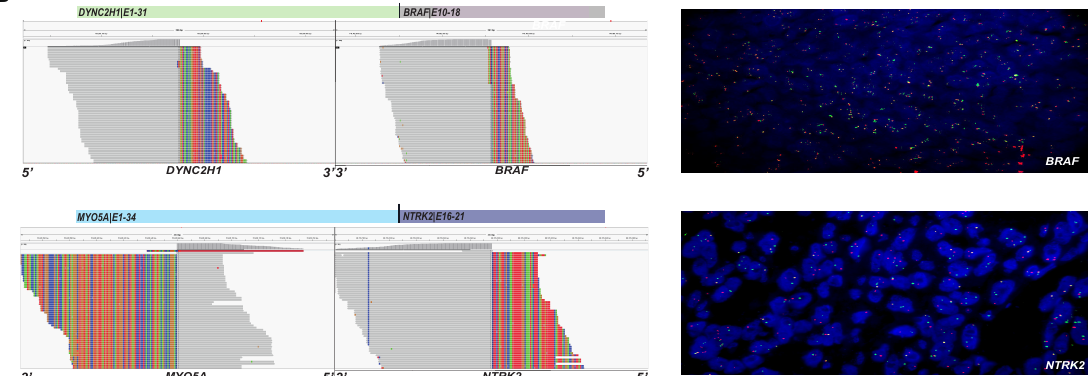
Figure 5. The novel fusions detected by panels. ( A ) The partners and drivers of novel fusions and representative H&E images; and ( B ) the further validation by